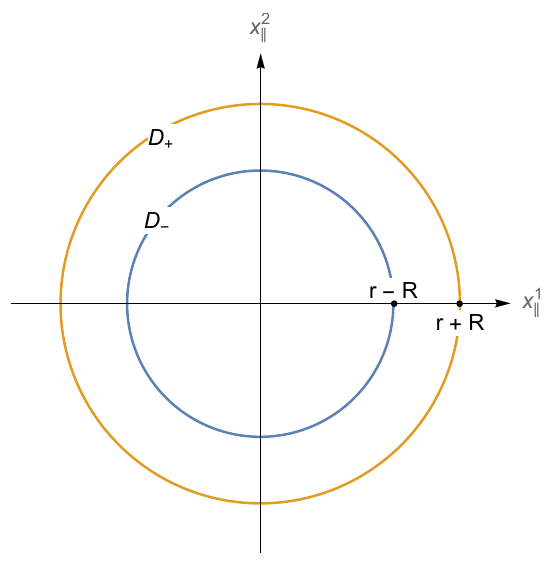
Figure 4 . The concentric circular defects are separated by a distance of 2 R